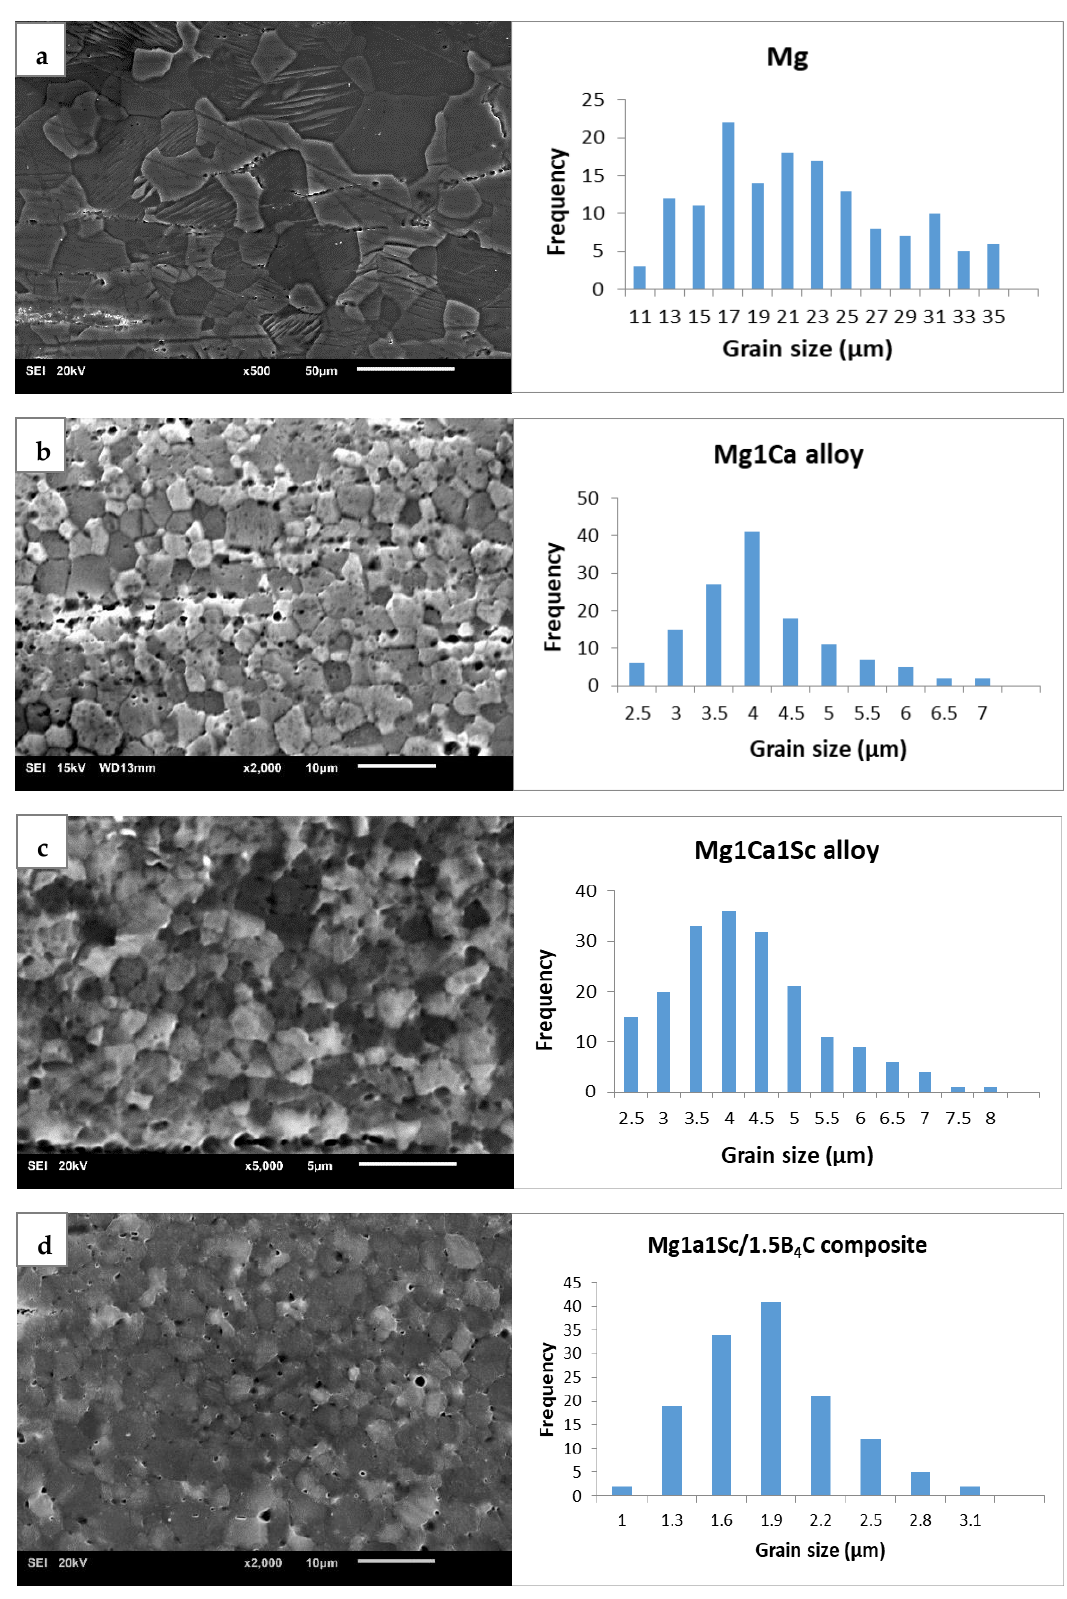
Figure 4. SEM micrographs showing grain sizes and distribution patterns in: ( a ) Mg, ( b ) Mg1Ca alloy, ( c ) Mg1Ca1Sc alloy and ( d ) Mg1Ca1Sc/B 4 C composite.